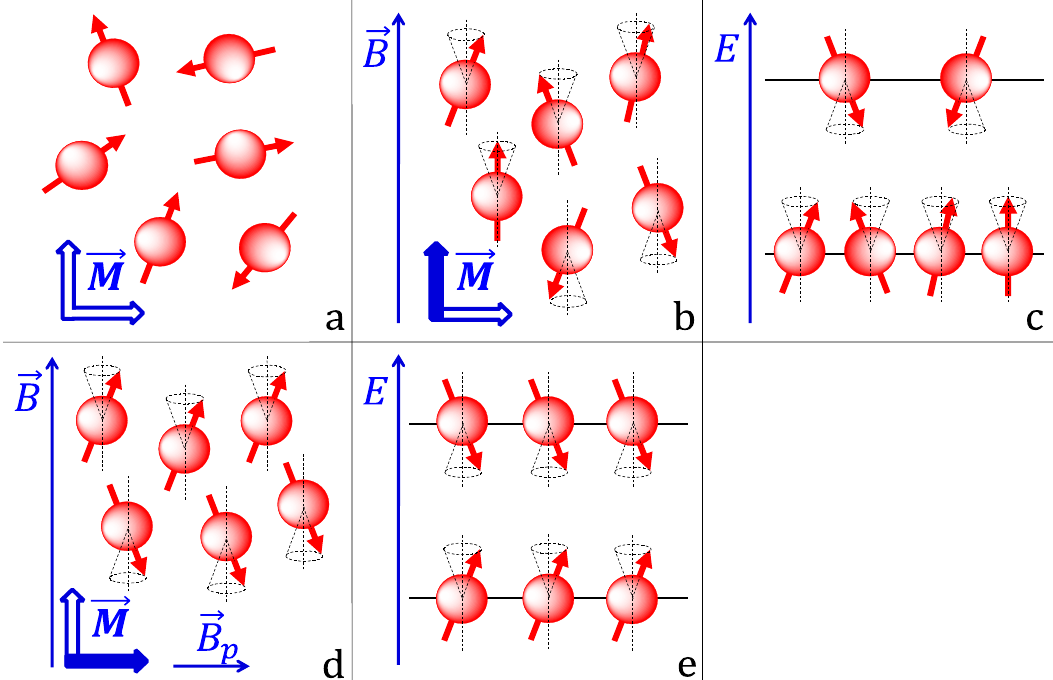
Figure 4. Depiction of spin and orientation of hydrogen nuclei under a magnet. ( a ) Nuclei displaying random orientation in the absence of a magnetic field. ( b ) Nuclei aligned along or against the magnetic field lines. ( d ) Nuclei aligned in equal amounts along and against magnetic field lines. ( c , e ) Nuclei separated into energy levels based on alignment.